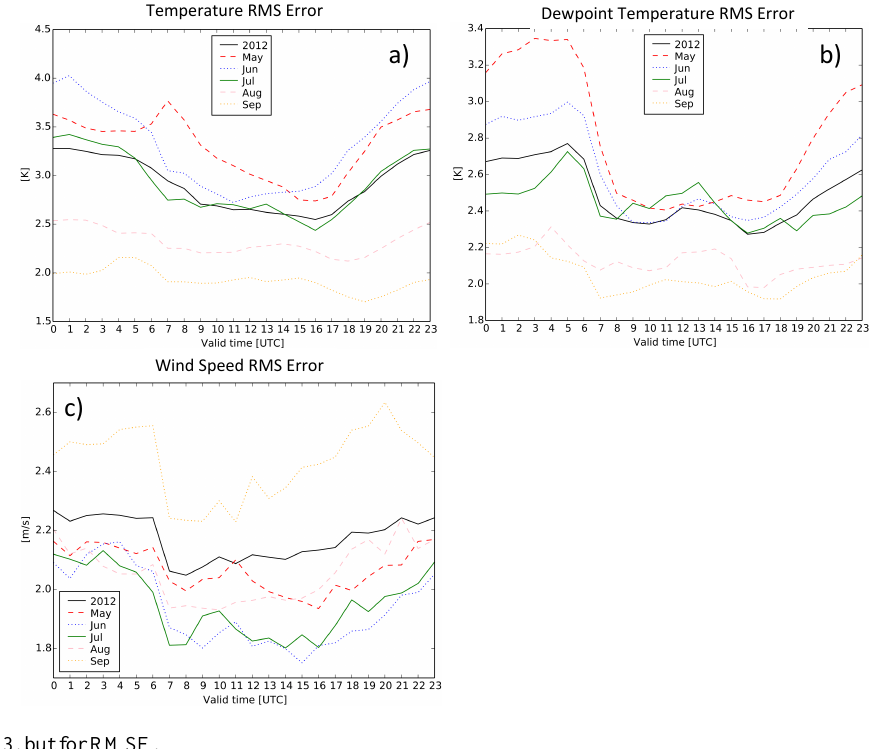
Figure 4. As in Fig. 3, but for